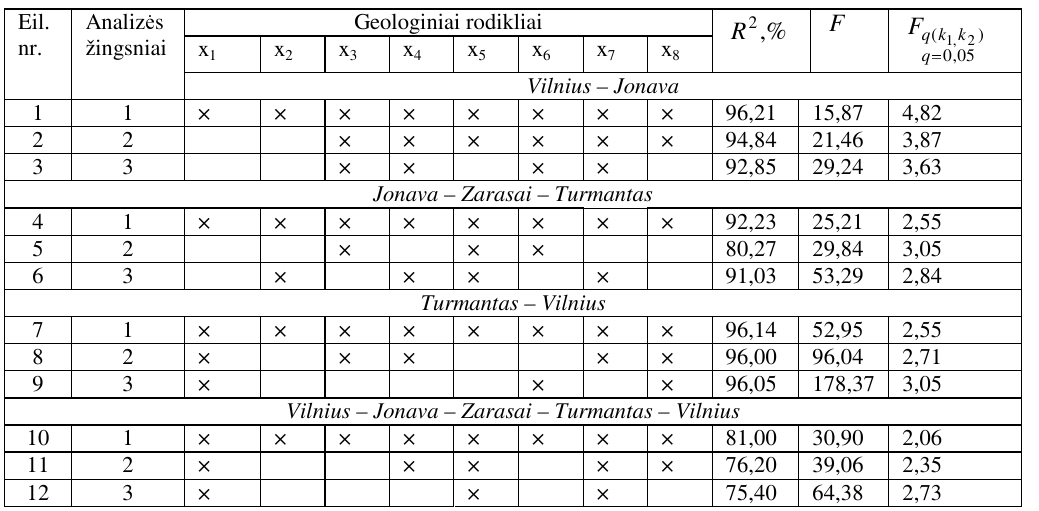
Table 2. The results of the regression analysis